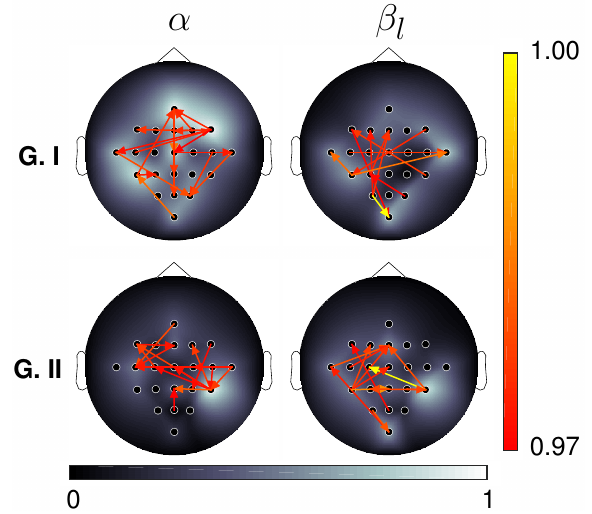
Figure 9. Topoplots of the average node (channel) relevance for each group of clustered subjects and frequency band of interest in the MI database (see Figure 8). The arrows represent the most relevant connectivities for each group. For visualization purposes, only 3% of the connections, those with the highest average relevance values per group, are depicted.